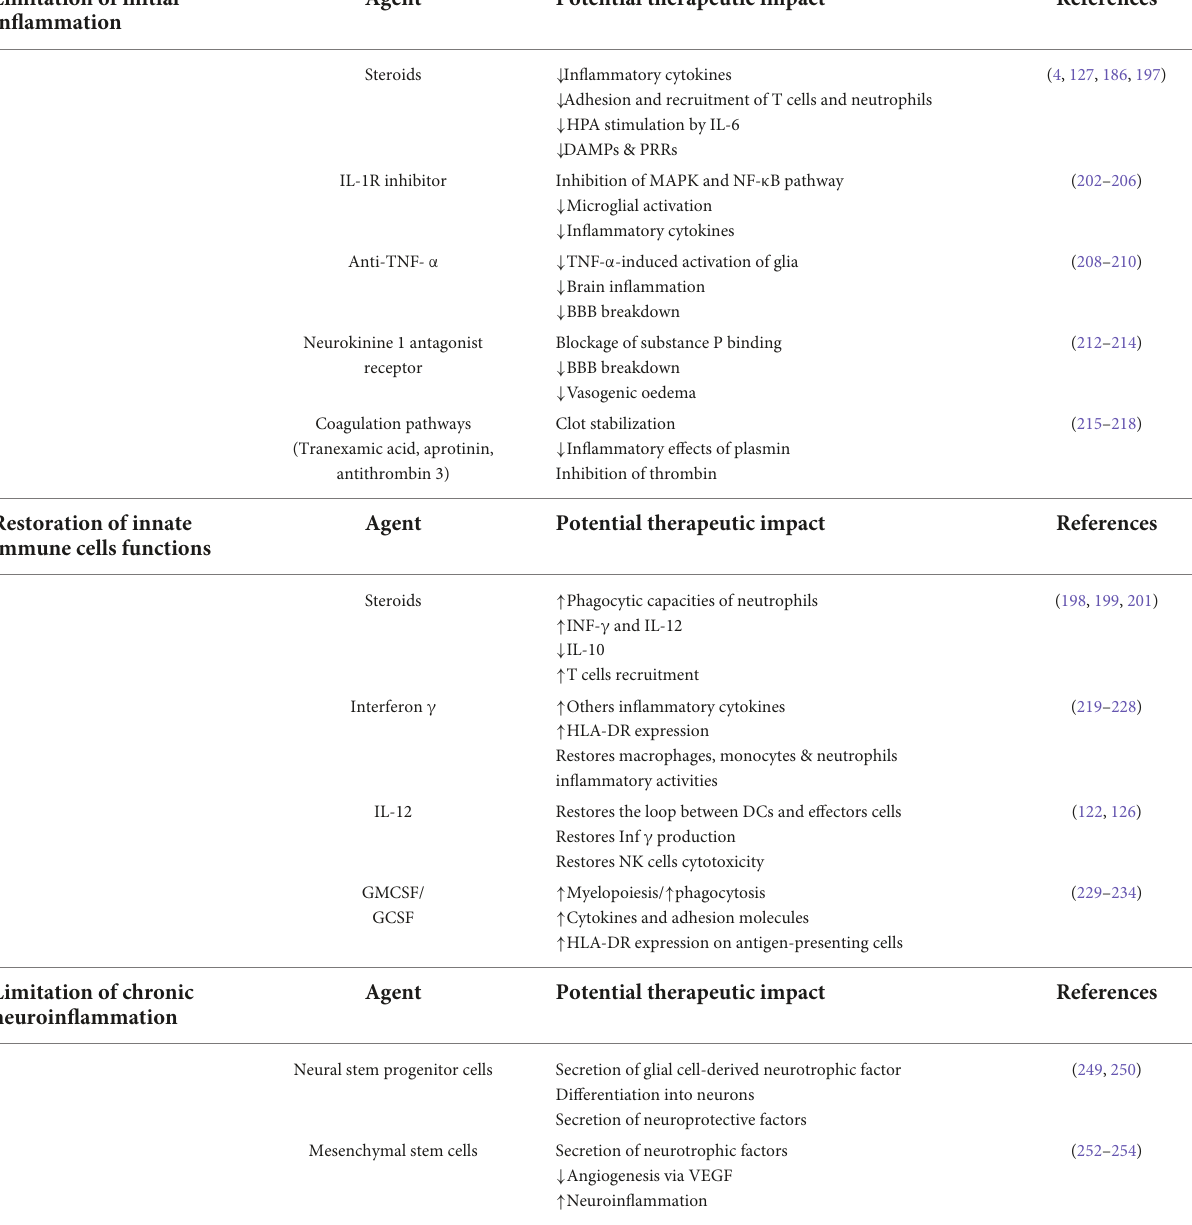
TABLE 1 Potential immunomodulating agents for the treatment of neuroinflammation and post-traumatic